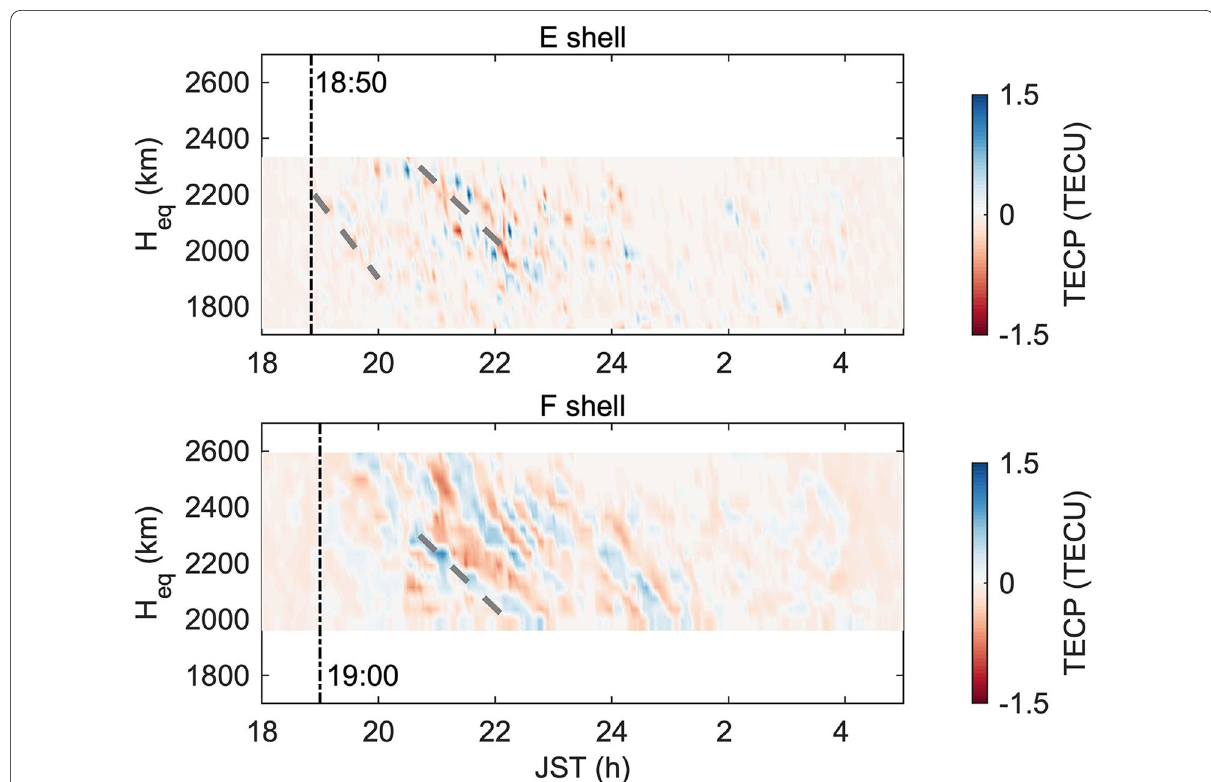
Fig. 11 Time variation of TECPs at E- (top) and F-shell heights (bottom) on 11 June 2007 (DOY 162), along the line from northeast to southwest indicated as the red dashed line in Fig. 1. The black and gray dashed lines represent the occurrence time of perturbations and the alignment of evident downward-sloping stripes,